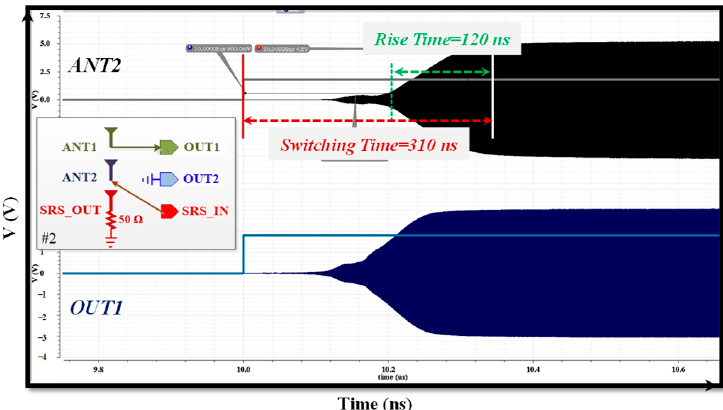
Figure 6. Measured results of the ( a ) RL and ( b ) harmonic distortion.